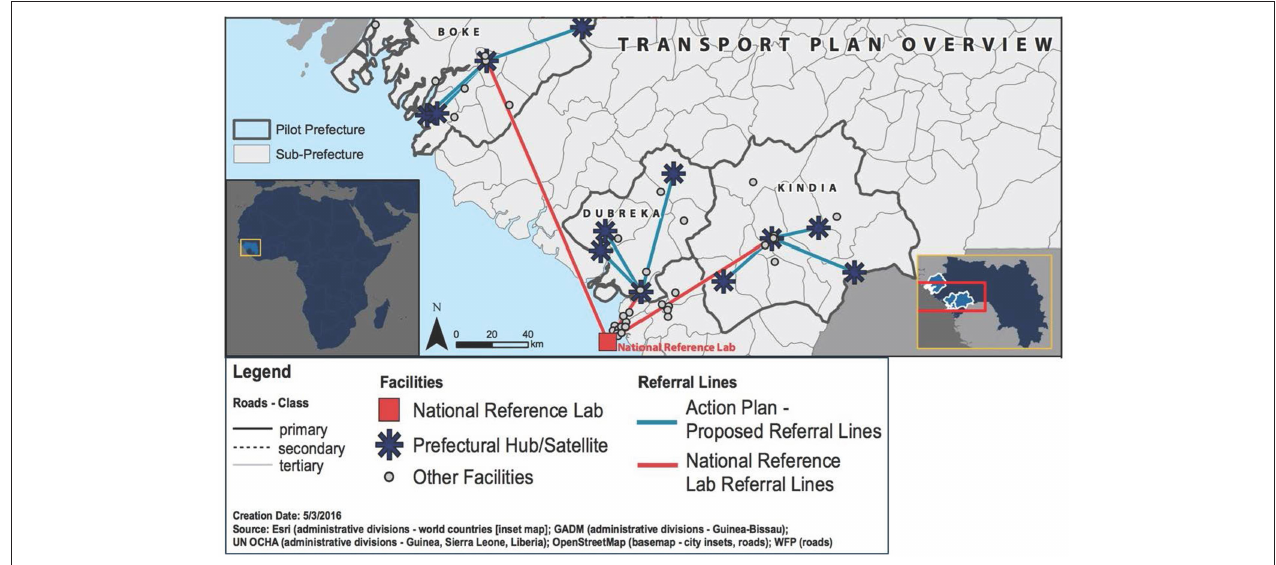
FIGURE 2 | Map showing the prefectures included in the pilot implementation project, including transportation plan